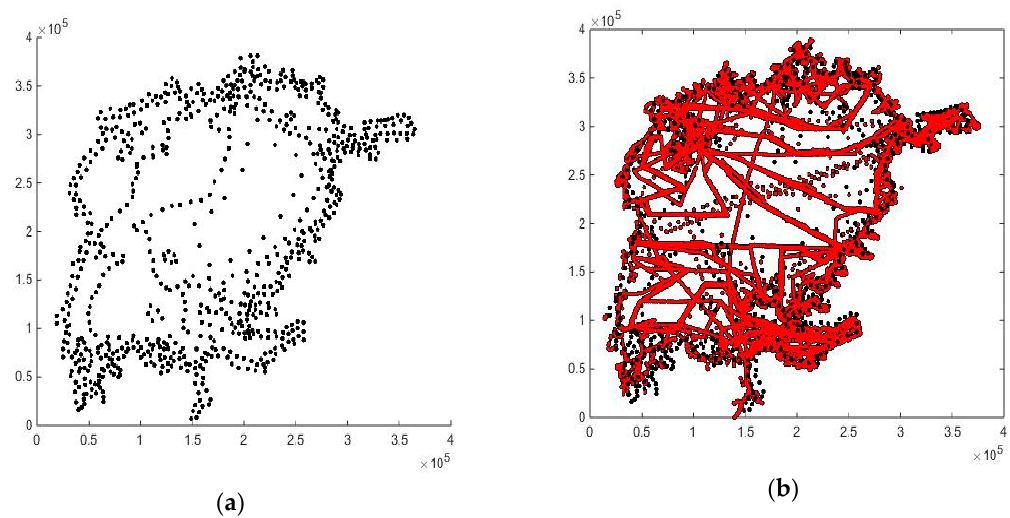
Figure 4. Bathymetry sources: ( a ) Depth iso-curves (60 m depth), and ( b ) NaFIRRI data. Satellite spectral remote sensing and echo sounders were used. The satellite data covered the lake surface and extended 15 km east–west and south–north of the lake (Figure 4b).